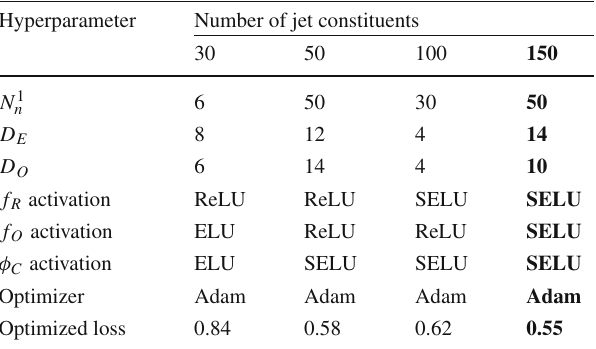
Table 1 Optimal JEDI-net hyperparameter setting for different input data sets, when the summed O i quantities are given as input to the φ C network. The best result, obtained when considering up to 150 particles per jet, is highlighted in bold Hyperparameter